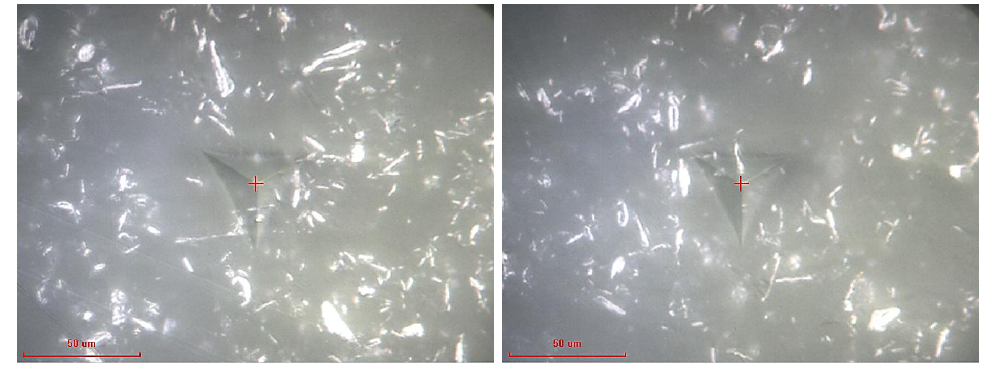
Figure 11. Micrographs of two indentation sites of 5 wt % CNP filled epoxy, representing indentation at or near CNP clusters.